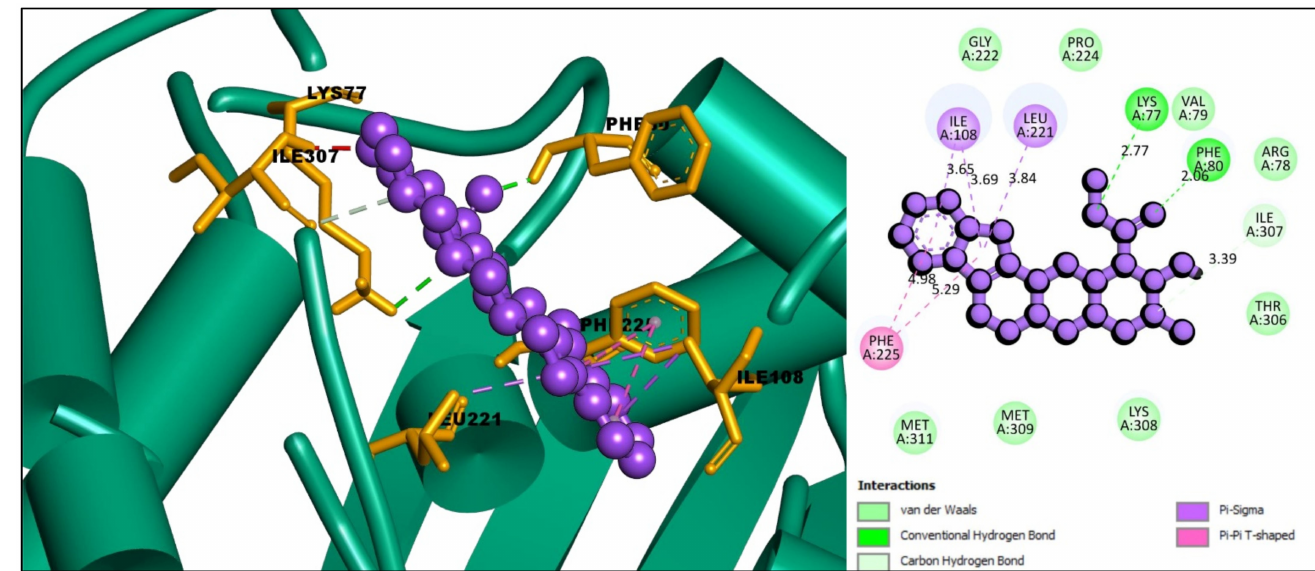
Figure 3. Interaction between the compound CID: 102004710 and thymidylate synthase. The left side represents 3D and the right side represents 2D complex interaction.